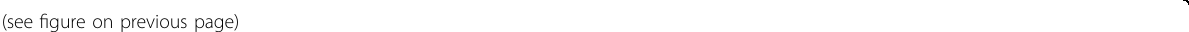
Fig. 4 Behavioral responses in GHSR KO mice of the GHSR LoxP/LoxP strain after CRE-mediated rescue of expression. As shown in Panel A , the GHSR LoxP/LoxP strain contains a Loxp- fl anked transcriptional blocking cassette (TBC) on the putative promoter region of the GHSR gene preventing GHSR expression. In the presence of CRE-recombinase, this TBC can be removed to restore expression at the site of recombination. Using Viral mediated CRE-recombination (see Panel A ), we were able to rescue GHSR expression in a subset of mice ( n = 5) to about 60% of control WT mice given a GFP expressing control virus ( n = 18; see Panel B ). The rescue was speci fi c to the VTA since no changes in GHSR expression were observed in the EWN of the same mice (see Panel B ). Analyses on the behavioral responses of these mice compared to those of unsuccessful GHSR rescue showed that this partial rescue was suf fi cient to reduce the latency to approach a conspeci fi c compared to that of GHSR LoxP/LoxP mice that received the control GFP ( n = 12) virus or GHSR LoxP/LoxP where the rescue was unsuccessful ( n = 10; p < 0.05; see Panel C ). Partial rescue of GHSR in the VTA was not suf fi cient to reduce the latency to approach a palatable food snack nor the frequency to approach the snack in the novel environment ( p > 0.05; see Panel D ). *Signi fi cantly different from control WT mice, p < 0.05; **signi fi cantly different from mice with unsuccessful rescue of GHSR mRNA expression, p <